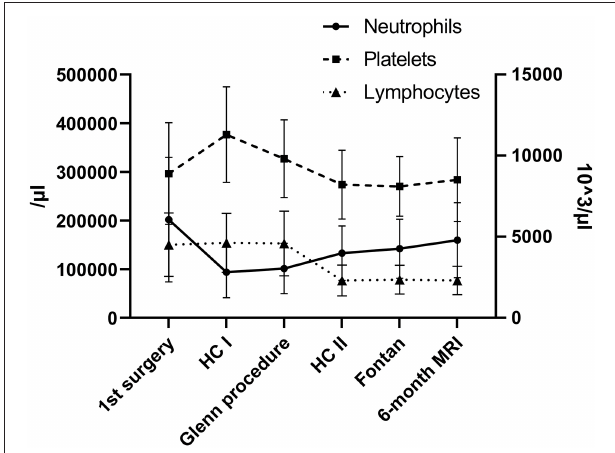
FIGURE 4 | Correlation of neutrophil-to-lymphocyte ratio (NLR) and platelet-to-lymphocyte ratio (PLR) to classification of lymphatic abnormalities from T2-weighted imaging data at 6-month magnetic resonance imaging (MRI). (A) NLR. (B) PLR.